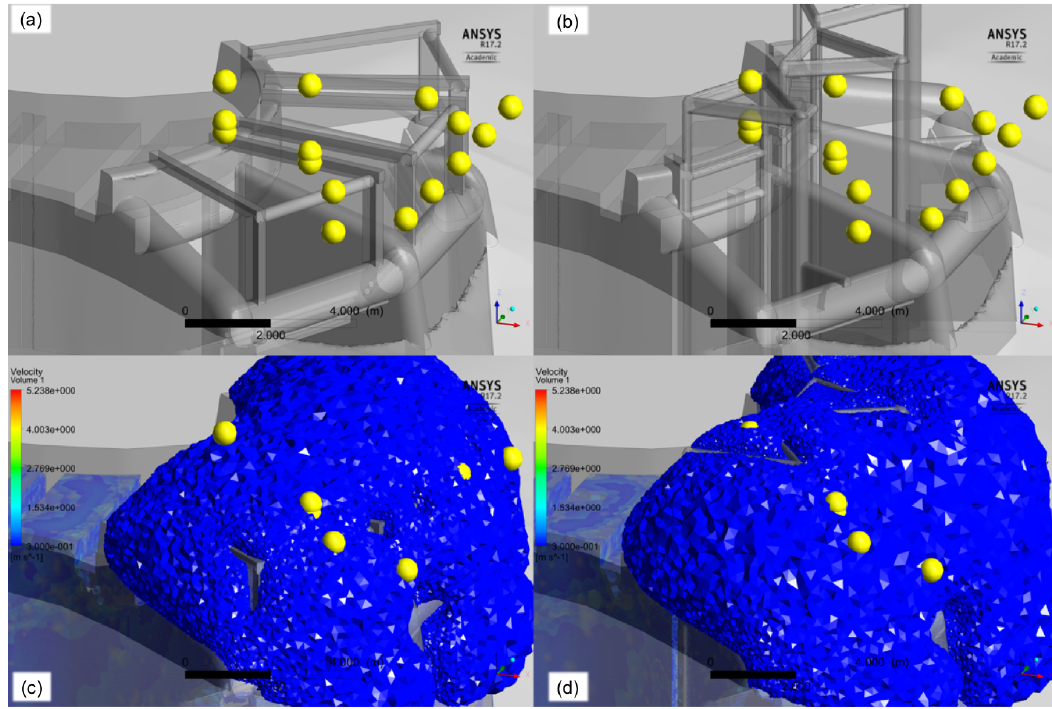
Figure 5. Comparison of the velocities at the measurement points with a velocity ≥ 0.3 m · s − 1 without ( a , b ) and with ( c , d ) volume analysis—build-on model E 01 (left column) and options E 02 (right column)—intake discharge Q = 60 m 3 · s − 1